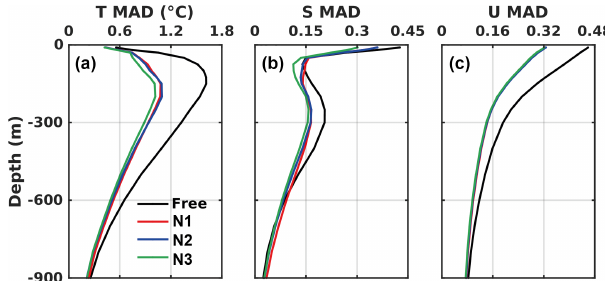
Figure 7. Profiles of MAD averaged over the open gulf (exclud- ing shelf regions shallower than 300m) and daily snapshots from 1 April to 1 October 2010 for (a) temperature ( T , ◦ ), (b) salinity ( S ), and (c) velocity ( U , ms − 1 ) from the free run and the noniden- tical twin